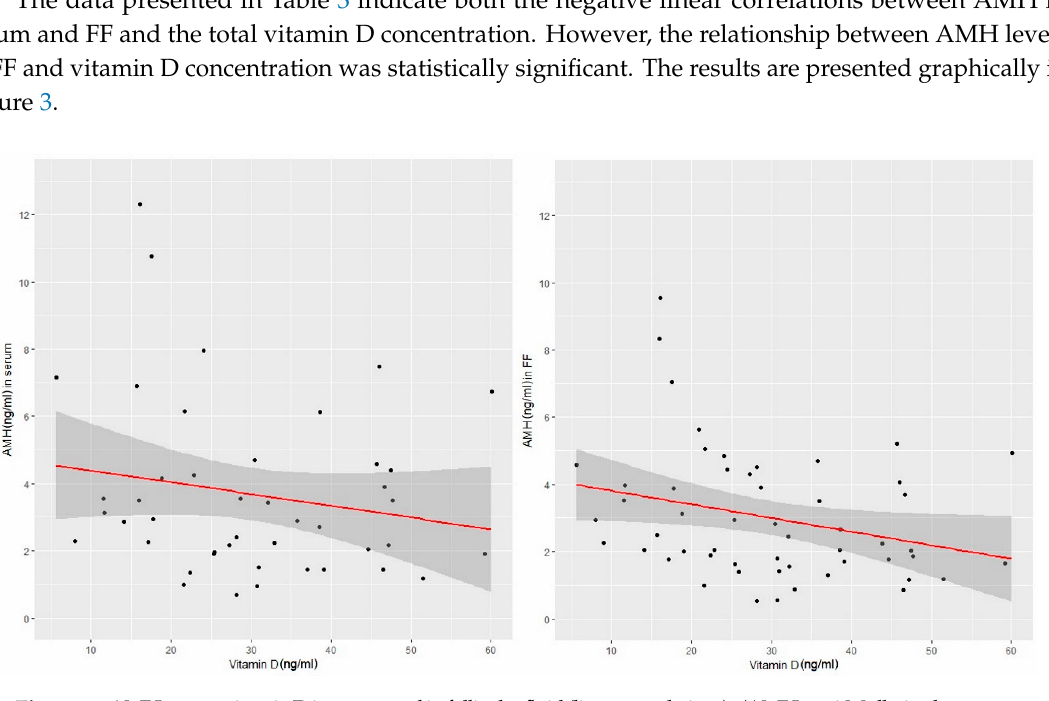
Figure 3. AMH versus vitamin D in serum and in follicular fluid (linear correlations). (AMH- anti- Figure3. AMHversusvitaminDinserumandinfollicularfluid(linearcorrelations). (AMH-anti-Müllerianhormone, Müllerian hormone, FF- follicular fluid). FF- follicular